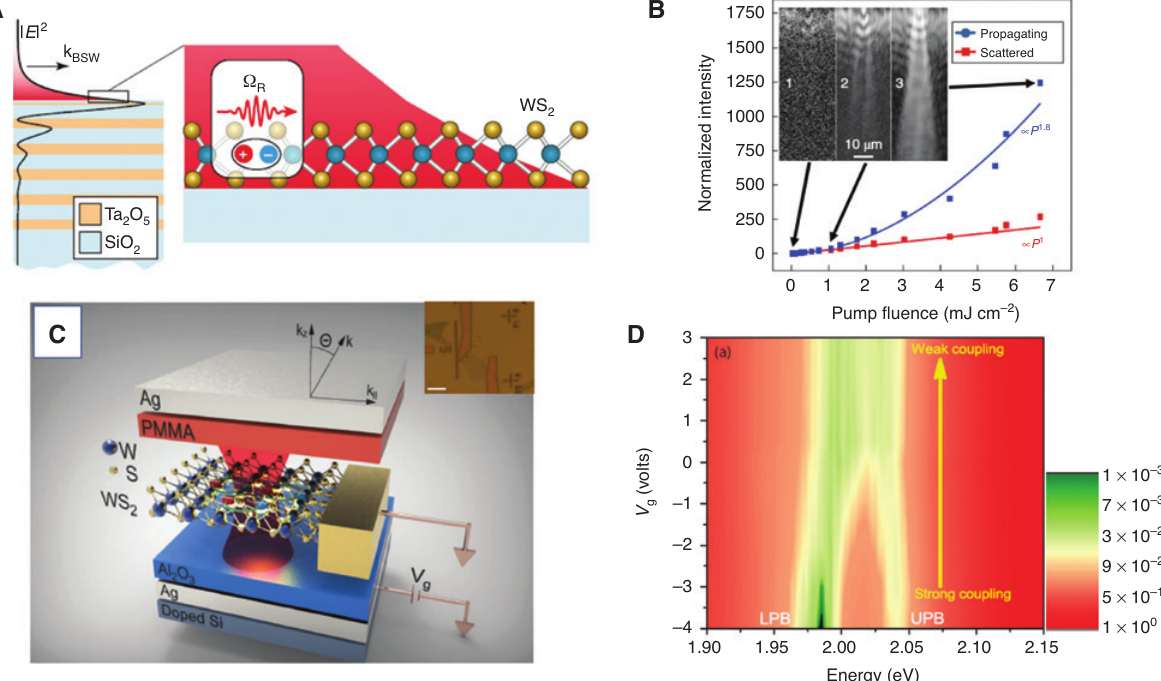
Figure 3: Polaritons in TMD MLs: nonlinearities and electrical control. (A) Coupling between a Bloch surface wave (BSW) at the DBR interface and a WS speed have been observed on this sample [45]. (B) Thanks to polariton-polariton interactions, a non-linear polariton source is obtained by resonantly pumping the device of Figure 1A. (C) A WS system from strong to weak coupling [42]. (D) Energy-resolved PL from the sample of Figure 2C as a function of the applied voltage V